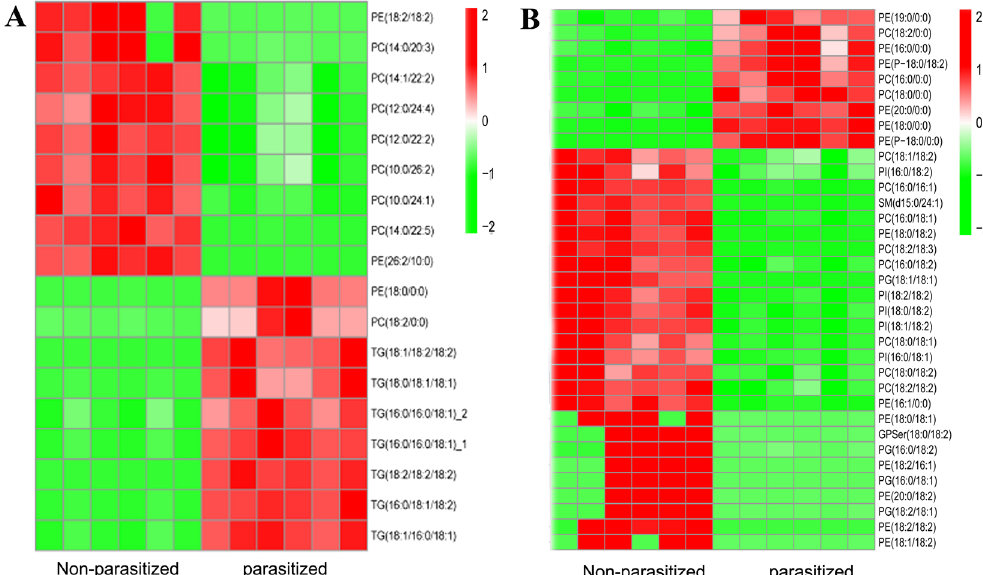
Figure 4. Heatmaps of the integration of intermatrix Lipids correlation between D vs F ( A - POS, B - NEG). Heat maps were applied to display the quantitative expression of lipids with a red color gradient representing high expression and a green color gradient representing low expression. Lipid synthesis metabolites with significant changes in the non-parasitized aphids and parasitized aphids groups from UHPLC-Q-TOF-MS was analyzed in the heatmap (VIP > 1, p value < 0.05). Scale bars on the top right of each heatmap represent the degree of gene expression with red showing high expression and green indicating low expression.